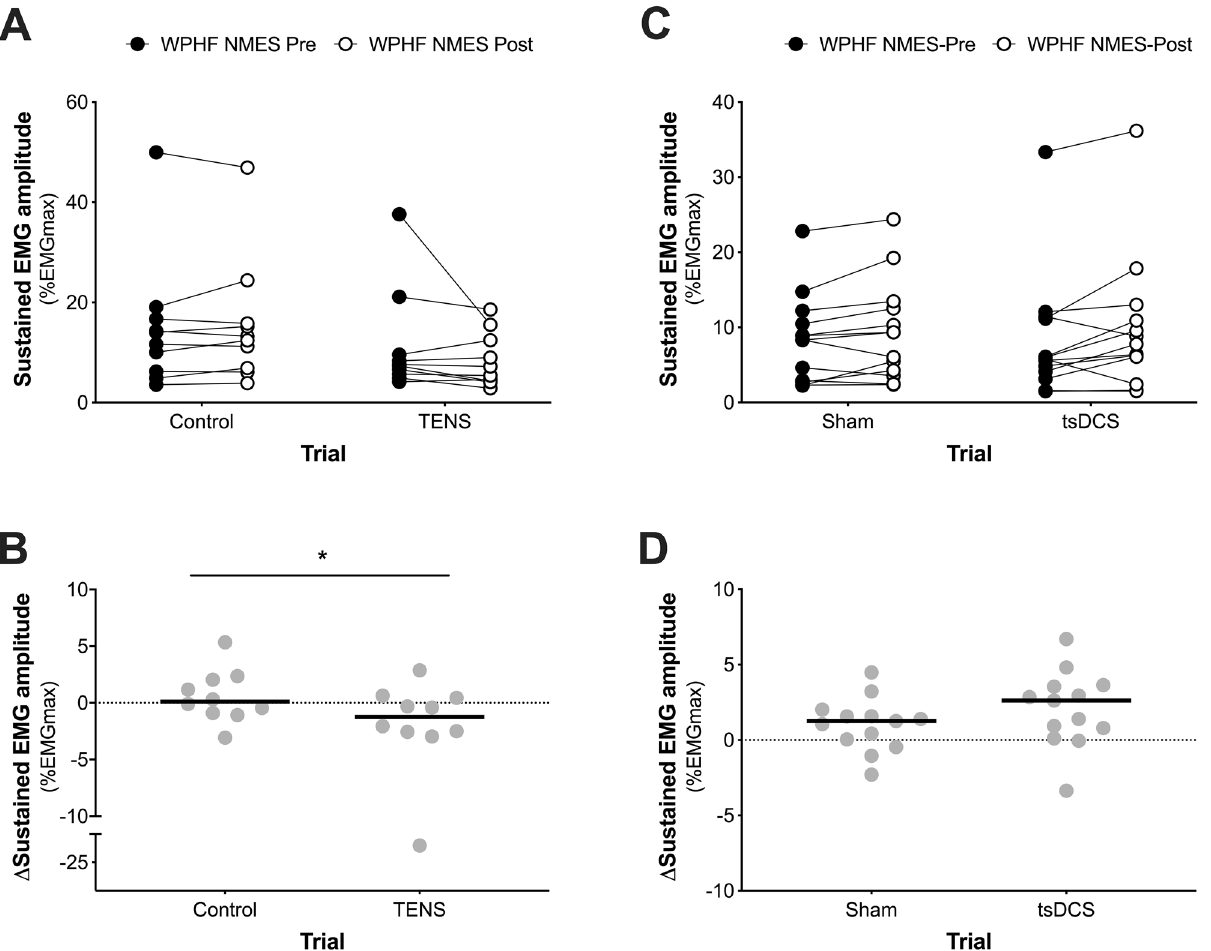
Figure 5. (A) Sustained EMG amplitude recorded before (WPHF NMES-Pre) and after (WPHF NMES-Post) a 15-min period of TENS (TENS trial) or no stimulation (Control trial). (B) Change in sustained EMG amplitude after a 15-min period of TENS (TENS trial) or no stimulation (Control trial). (C) Sustained EMG amplitude recorded before (WPHF NMES-Pre) and after (WPHF NMES-Post) a 20-min period of tsDCS (tsDCS trial) or sham stimulation (Sham trial). (D) Change in sustained EMG amplitude recorded after a 20-min period of tsDCS (tsDCS trial) or sham stimulation (Sham trial). Data are presented as individual data points and the line represents the median. *Significant difference between trials ( P = 0.005). A significant reduction in EMG activity was observed in the period immediately after the cessation of wide-pulse, high-frequency NMES stimulations when imposed after a bout of TENS compared to the control condition (A,B) . In the tsDCS experiment (C,D) no significant change in EMG activity was observed in the period immediately after the cessation a wide-pulse, high-frequency NMES stimulation was imposed after a bout of tsDCS compared to the sham